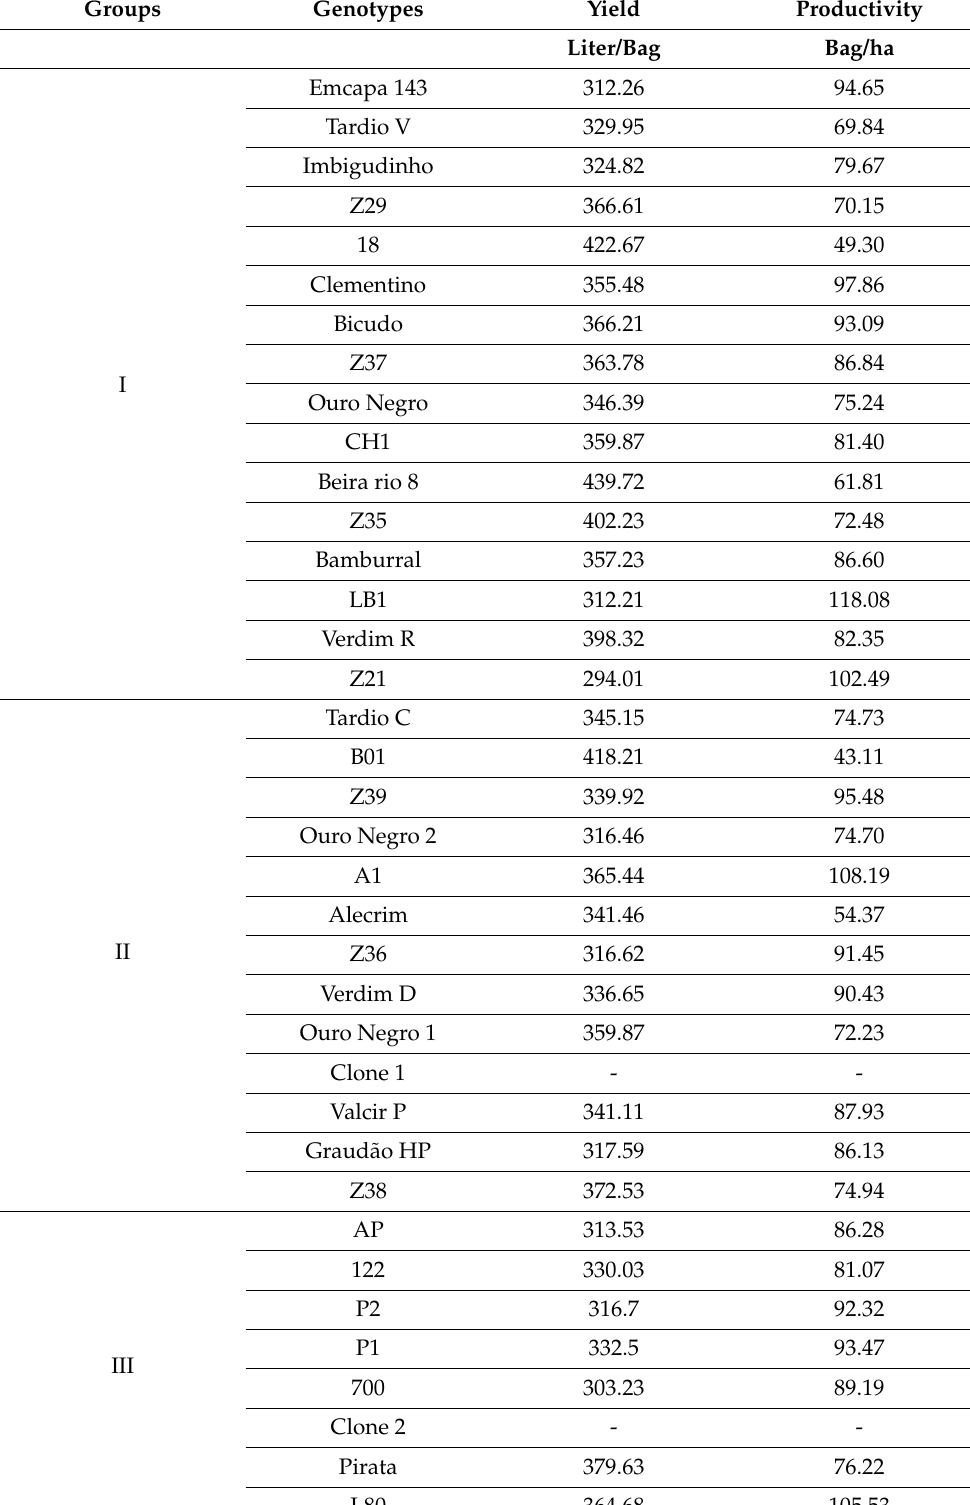
Table 2. Mean yield in liters of coffee per 60 kg bag and productivity of the genotypes in the groups defined by microsatellite markers using the UPGMA clustering